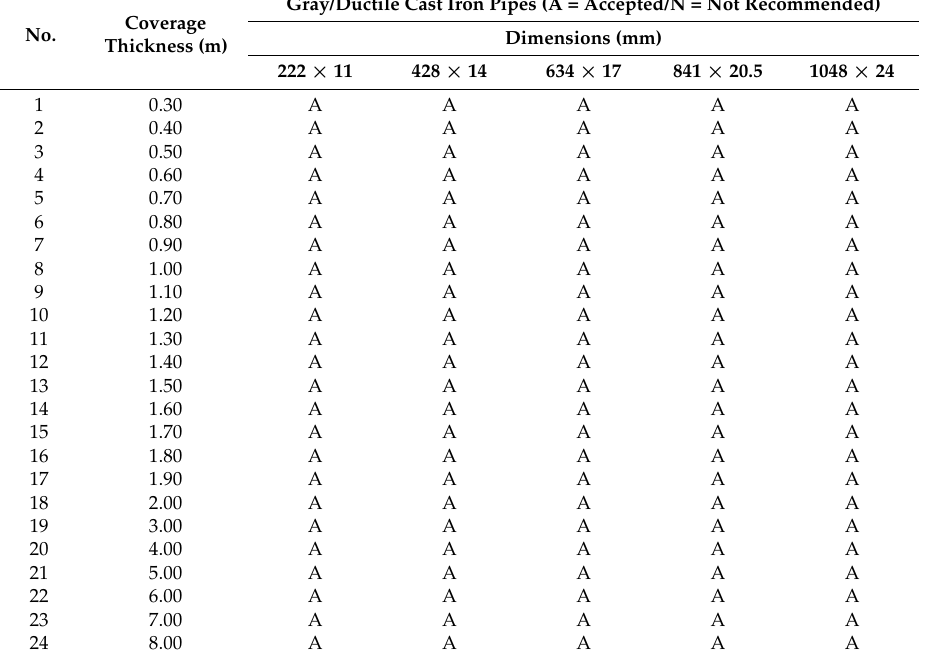
Table 12. Results of the calculations for the cast iron